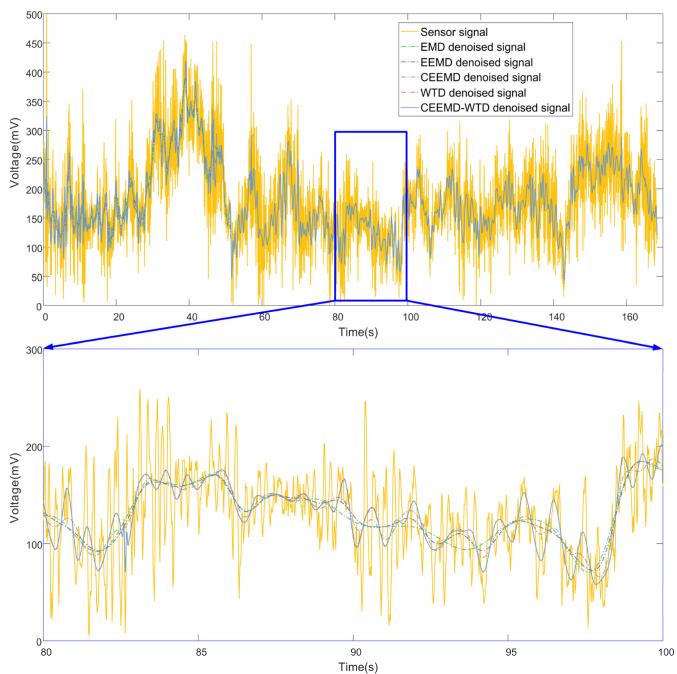
Figure 17. Time domain diagram of the sensor signal after